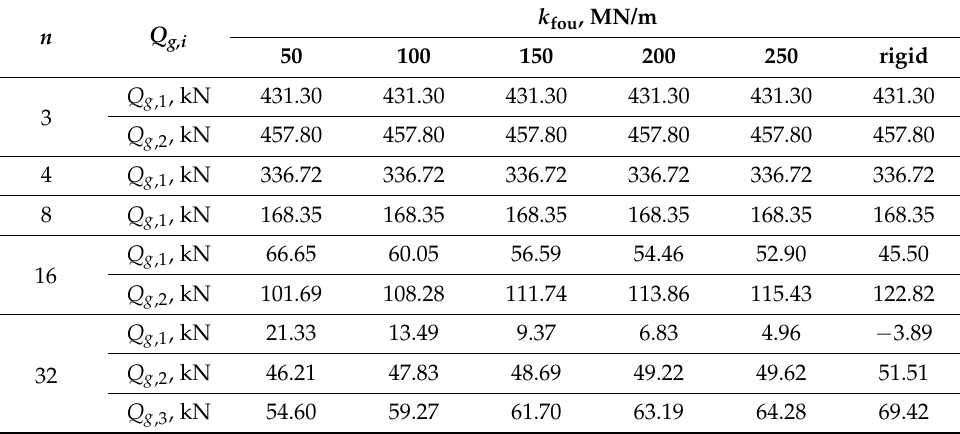
Table A15. Force Q g, in the jacks depending on the n number of the jacks and stiffness k fou of jack